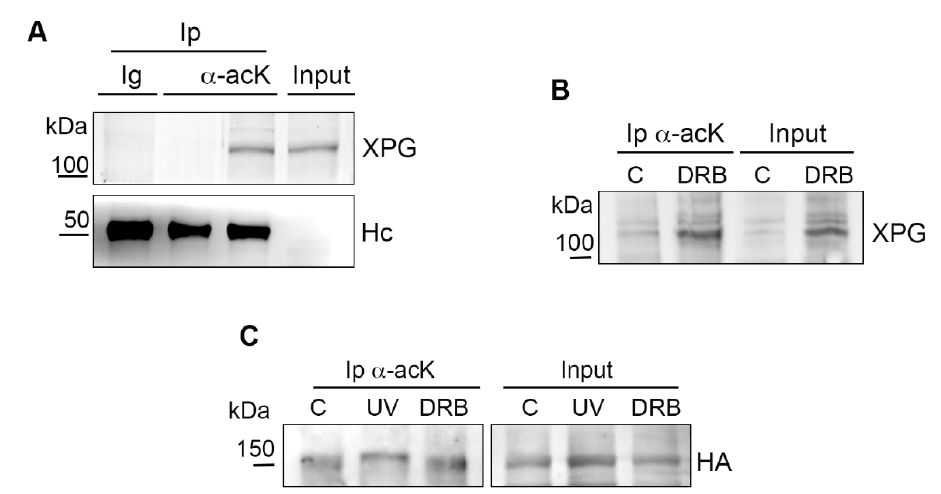
Figure 2. XPG acetylation is not affected by inhibition of transcription. ( A ) Specificity of immunoprecipitation (Ip) of acetylated XPG was tested in LF-1 cell extracts by incubation with purified immunoglobulin G (Ig), or with anti-acK antibody in the absence of HDAC inhibitors. Hc: Ig heavy chains. ( B ) Immunoprecipitation (Ip) of acetylated proteins with anti-acK antibody from LF-1 chromatin-bound nuclear extracts of (C) untreated or DRB-treated samples. Western blot analysis of XPG in input and Ip is shown. Input loading is 1/10 of total nuclear extracts. ( C ) Immunoprecipitation of acetylated proteins with anti acK antibody from chromatin-bound nuclear extracts of HEK293 cells expressing HA-tagged XPG. Untreated (C), UV-irradiated (10 J/m 2 ), and DRB-treated samples are shown. Western blot analysis of HA-tagged XPG in the input and Ip is shown. Input loading is 1/10 of total nuclear extracts.